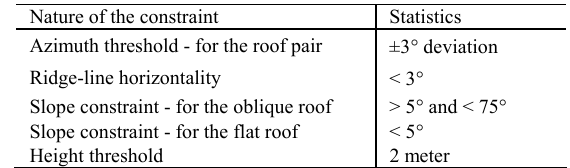
2 meter Figure 2: A complex roof structure (left) and its RTG, G